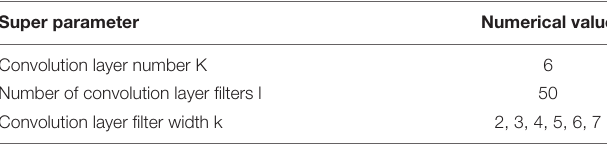
TABLE 5 | Super parameters of the improved model.